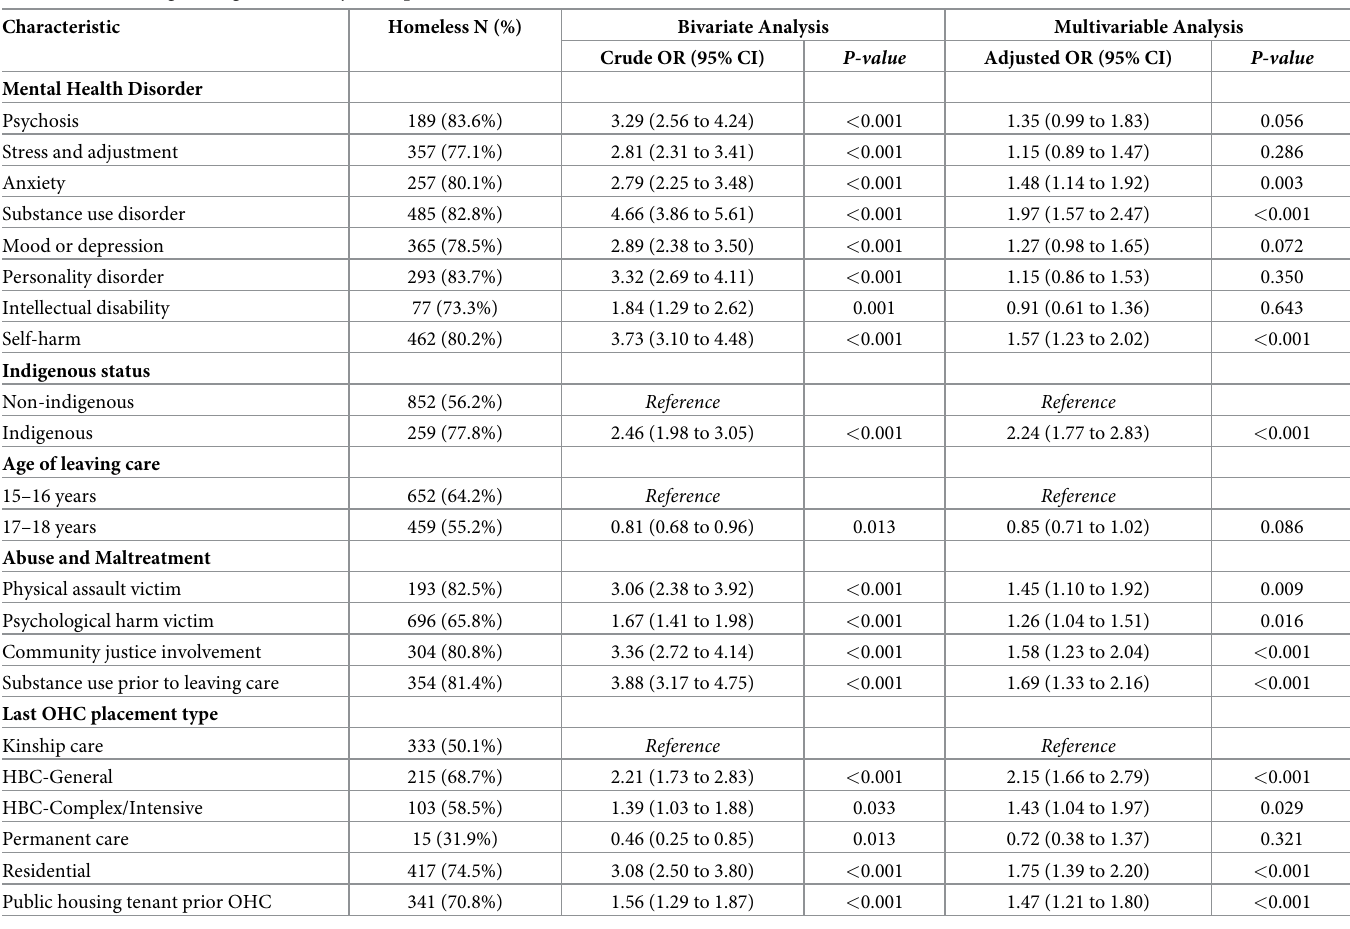
Table 4. Ordered logistic regression analysis for predictors of homelessness